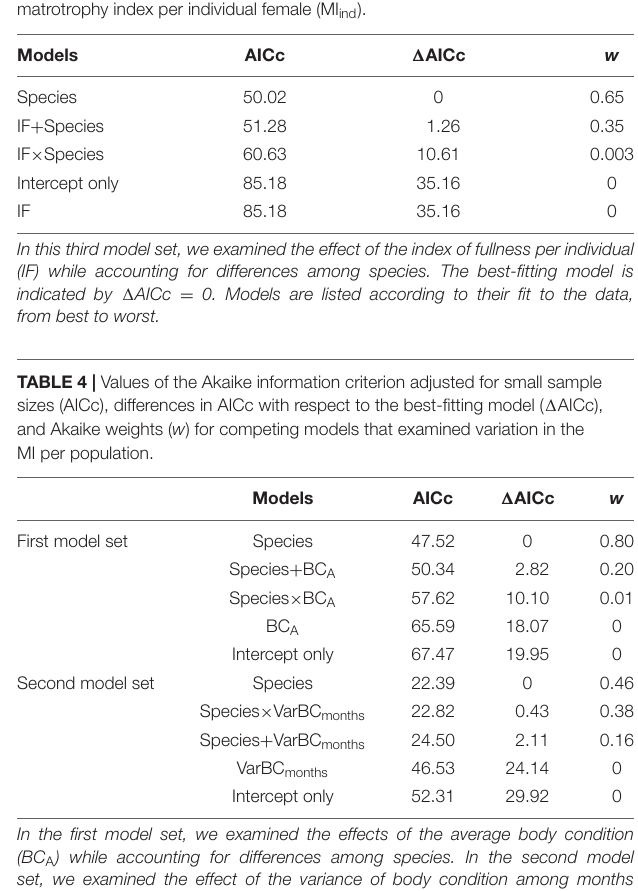
TABLE 3 | Values of the Akaike information criterion adjusted for small sample sizes (AICc), differences in AICc with respect to the best-fitting model ( (cid:49) AICc), and Akaike weights ( w ) for competing models that examined variation in the matrotrophy index per individual female (MI ind ).